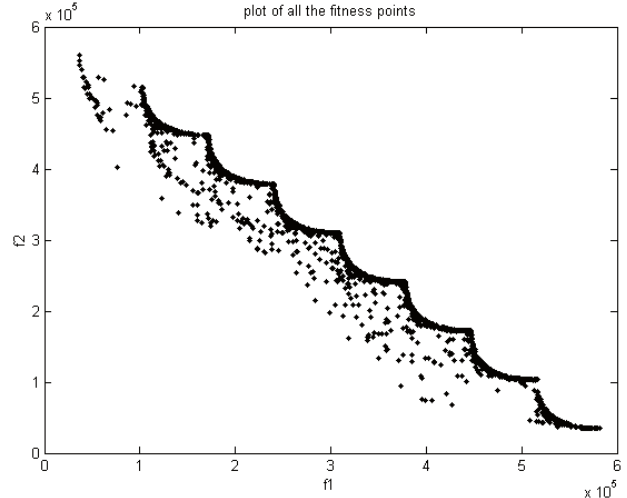
Fig. 6. Feasible domain for maximization problem of A11 (F 1 ) and A22 (F 2 ) for 8 staking.